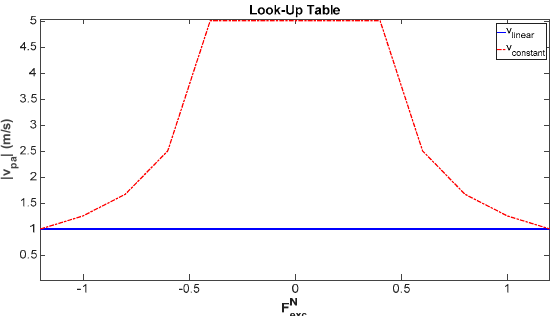
Figure 13. Two different approaches for the Look-up table of Velocity Amplitude Control. Figure 13. Two di ff erent approaches for the Look-up table of Velocity Amplitude Control.